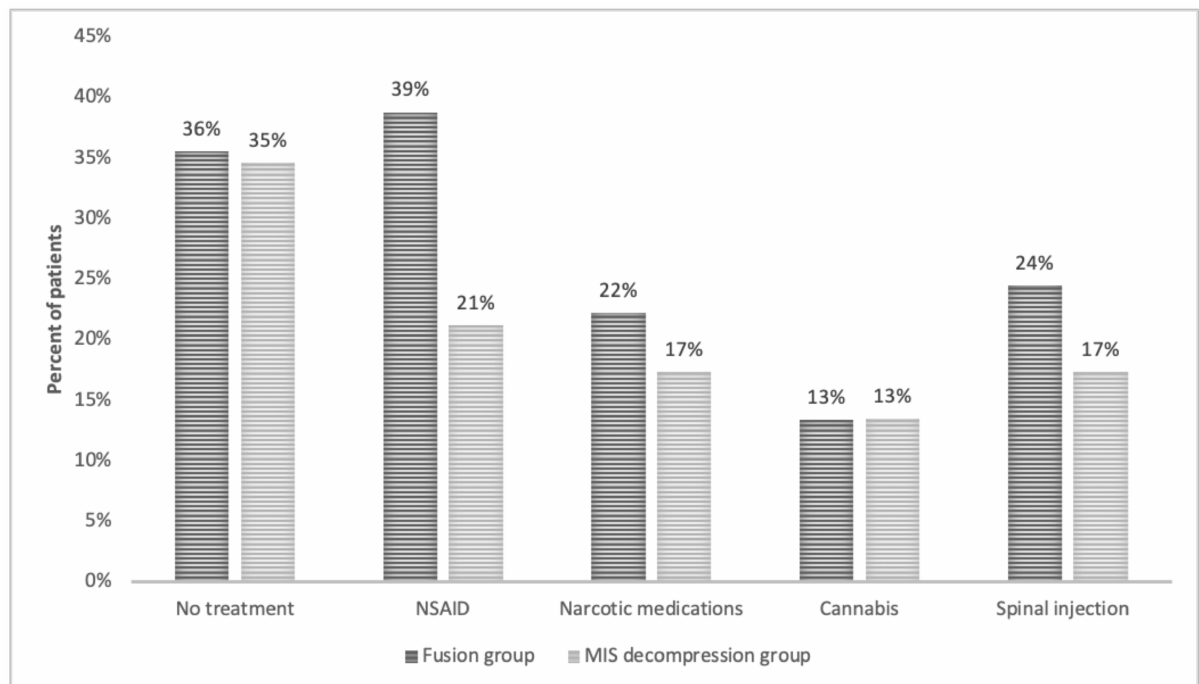
Figure 5. Chronic pain treatments among the MIS and fusion